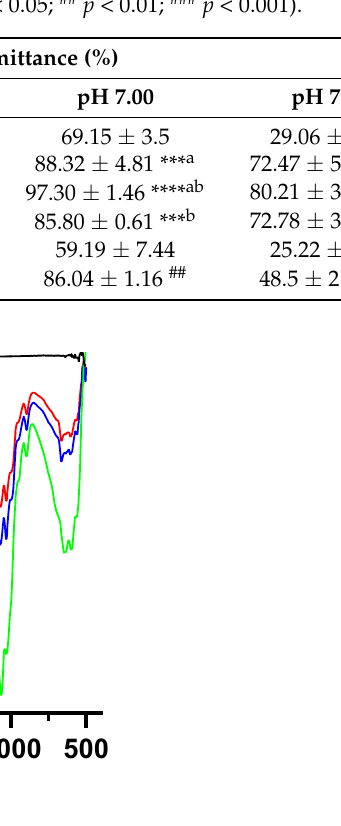
Figure 2. FTIR spectra of NaF (black), CS3H (green), CS3H Lys (blue), and CS3H Lys F (red).